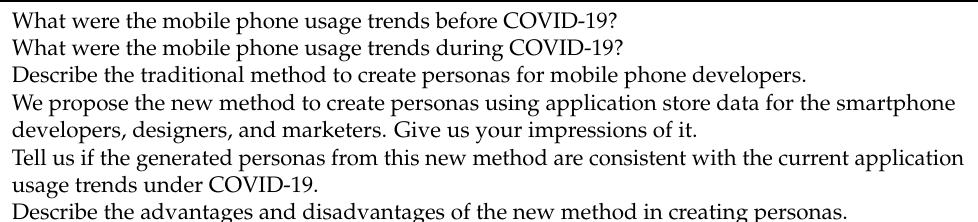
Table 2. Questions list for the expert